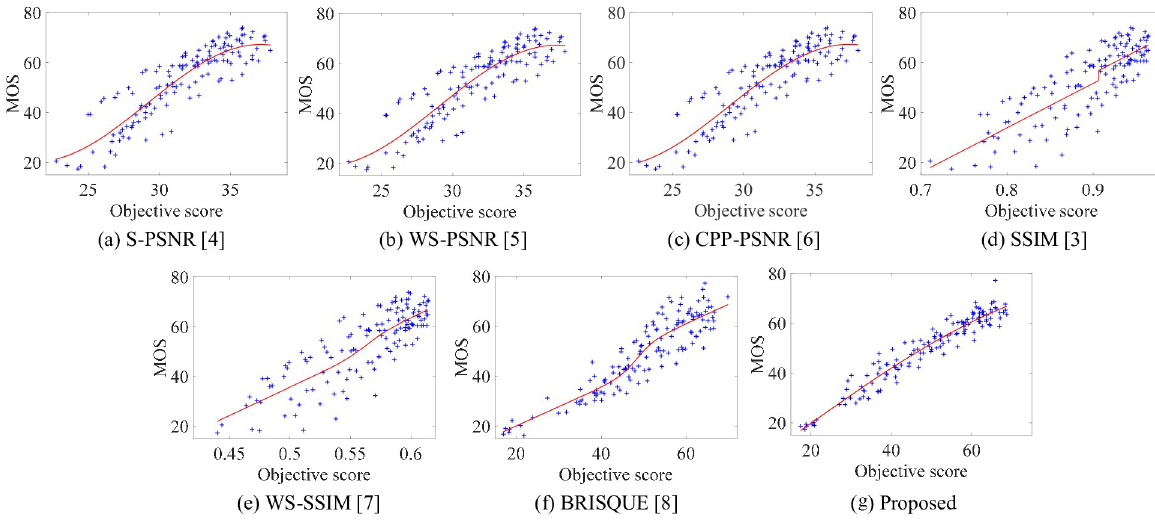
Fig 7. Scatter diagrams for the pairs of MOS score and objective score of different algorithms. (a) S-PSNR [4]. (b) WS-PSNR [5]. (c) CPP-PSNR [6]. (d) SSIM [3]. (e) WS-SSIM [7]. (f) BRISQUE [8]. (g) Proposed.